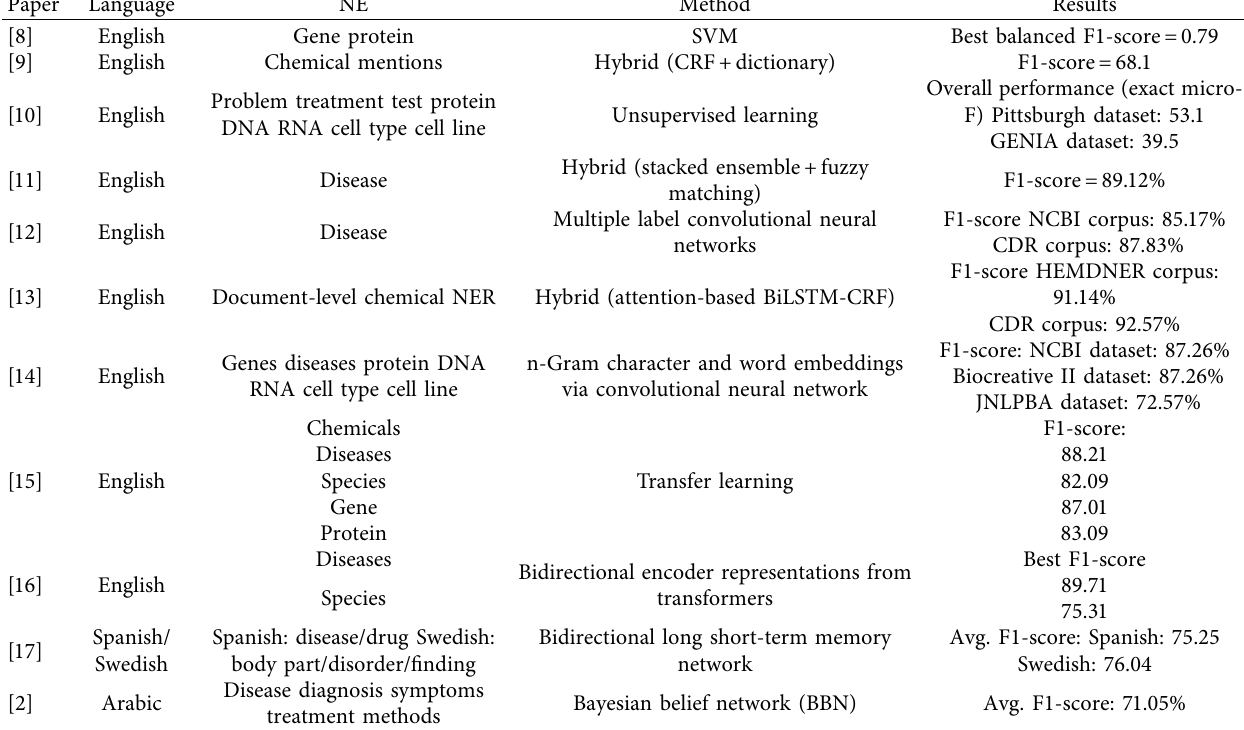
Table 1: An overview of methods used for biomedical named-entity